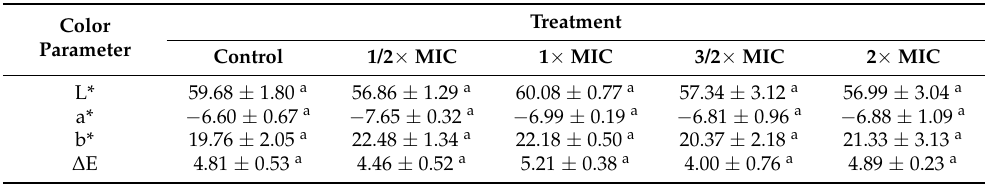
concentrations of linalool. Different letters indicate a significant difference cross the table ( p <